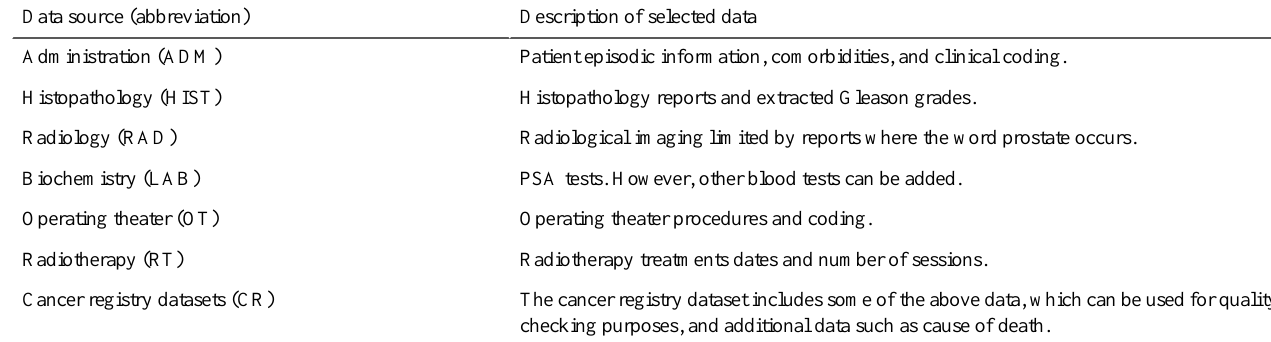
Table 1. Data sources used for the development of the